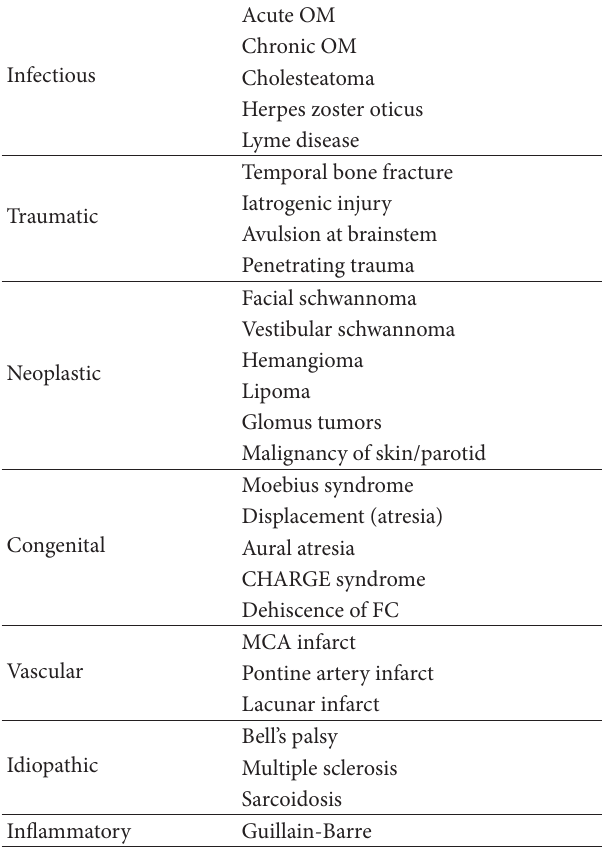
Table 1: Disorders of the facial